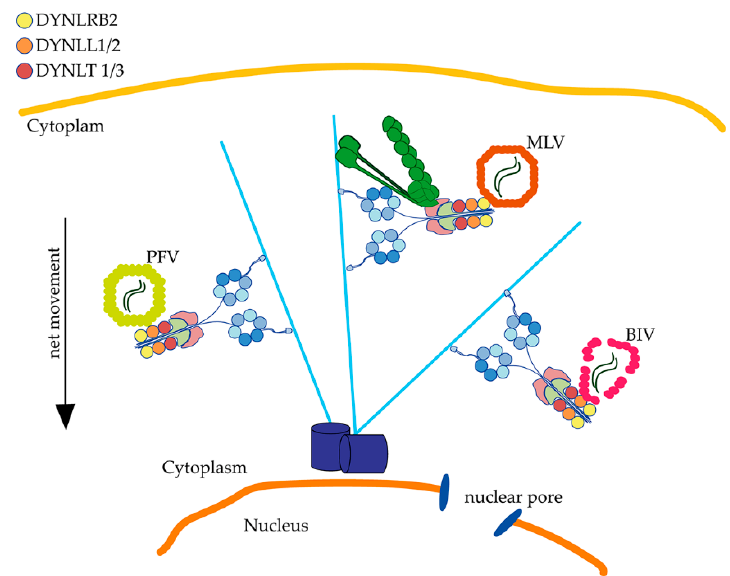
Figure 2. Retroviruses associate with dynein by direct interaction with light chains. Dynein light chains are essential for primate foamy virus (PFV), murine leukemia virus (MLV) and Bovine immunodeficiency virus (BIV) infection. PFV and BIV directly associate through Gag or CA to DYNLL for their retrograde transport. MLV requires dynein and dynactin for infection, and although no physical interaction has been demonstrated, the light chain DYNLRB2 is functionally required for MLV infection.